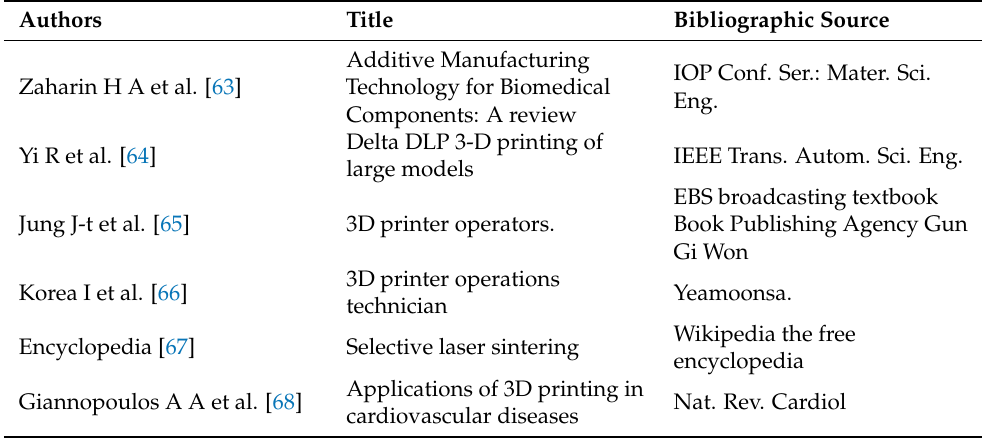
Table 4. Systematization/enumeration of three-dimensional printing papers with bibliographic